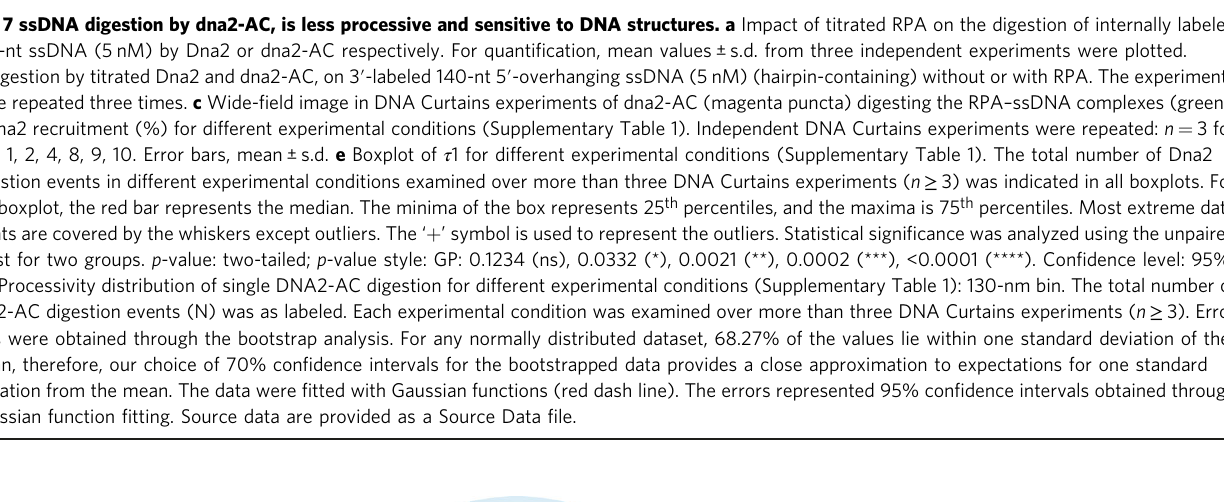
Fig. 7 ssDNA digestion by dna2-AC, is less processive and sensitive to DNA structures. a Impact of titrated RPA on the digestion of internally labeled 562-nt ssDNA (5 nM) by Dna2 or dna2-AC respectively. For quanti fi cation, mean values ± s.d. from three independent experiments were plotted. b Digestion by titrated Dna2 and dna2-AC, on 3 ′ -labeled 140-nt 5 ′ -overhanging ssDNA (5 nM) (hairpin-containing) without or with RPA. The experiments were repeated three times. c Wide- fi eld image in DNA Curtains experiments of dna2-AC (magenta puncta) digesting the RPA – ssDNA complexes (green). d Dna2 recruitment (%) for different experimental conditions (Supplementary Table 1). Independent DNA Curtains experiments were repeated: n = 3 for Exp. 1, 2, 4, 8, 9, 10. Error bars, mean ± s.d. e Boxplot of τ 1 for different experimental conditions (Supplementary Table 1). The total number of Dna2 digestion events in different experimental conditions examined over more than three DNA Curtains experiments ( n ≥ 3) was indicated in all boxplots. For the boxplot, the red bar represents the median. The minima of the box represents 25 th percentiles, and the maxima is 75 th percentiles. Most extreme data points are covered by the whiskers except outliers. The ‘ + ’ symbol is used to represent the outliers. Statistical signi fi cance was analyzed using the unpaired t -test for two groups. p -value: two-tailed; p -value style: GP: 0.1234 (ns), 0.0332 (*), 0.0021 (**), 0.0002 (***), <0.0001 (****). Con fi dence level: 95%. f – h Processivity distribution of single DNA2-AC digestion for different experimental conditions (Supplementary Table 1): 130-nm bin. The total number of dna2-AC digestion events (N) was as labeled. Each experimental condition was examined over more than three DNA Curtains experiments ( n ≥ 3). Error bars were obtained through the bootstrap analysis. For any normally distributed dataset, 68.27% of the values lie within one standard deviation of the mean, therefore, our choice of 70% con fi dence intervals for the bootstrapped data provides a close approximation to expectations for one standard deviation from the mean. The data were fi tted with Gaussian functions (red dash line). The errors represented 95% con fi dence intervals obtained through Gaussian function fi tting. Source data are provided as a Source Data fi le.